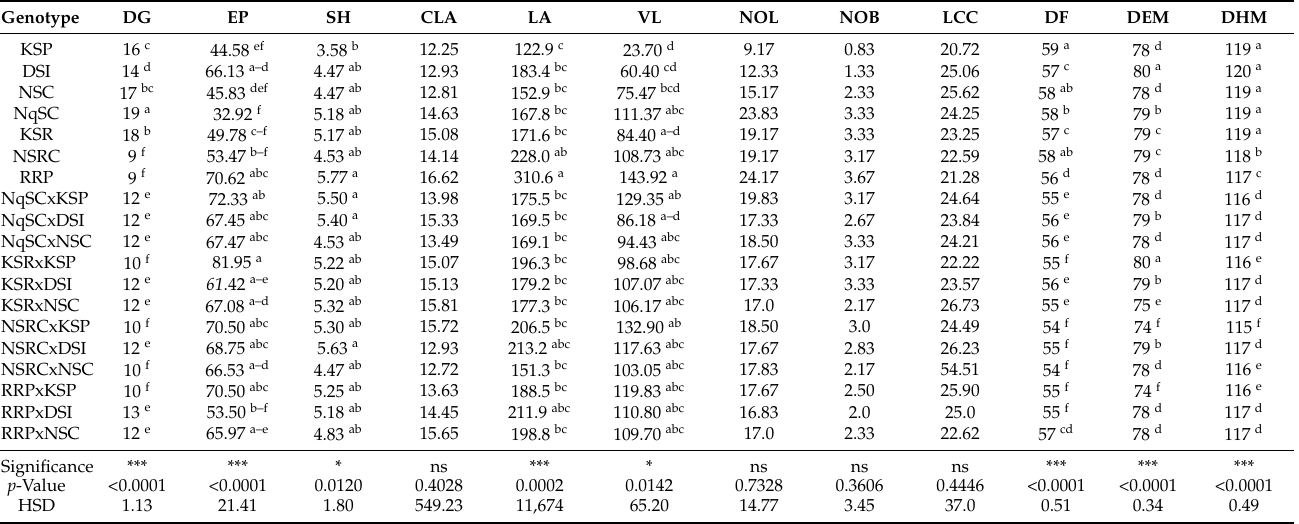
Table 3. Variation in seedling traits at 25 days after planting; vegetative traits and growth traits (50 DAP) among Lagenaria siceraria